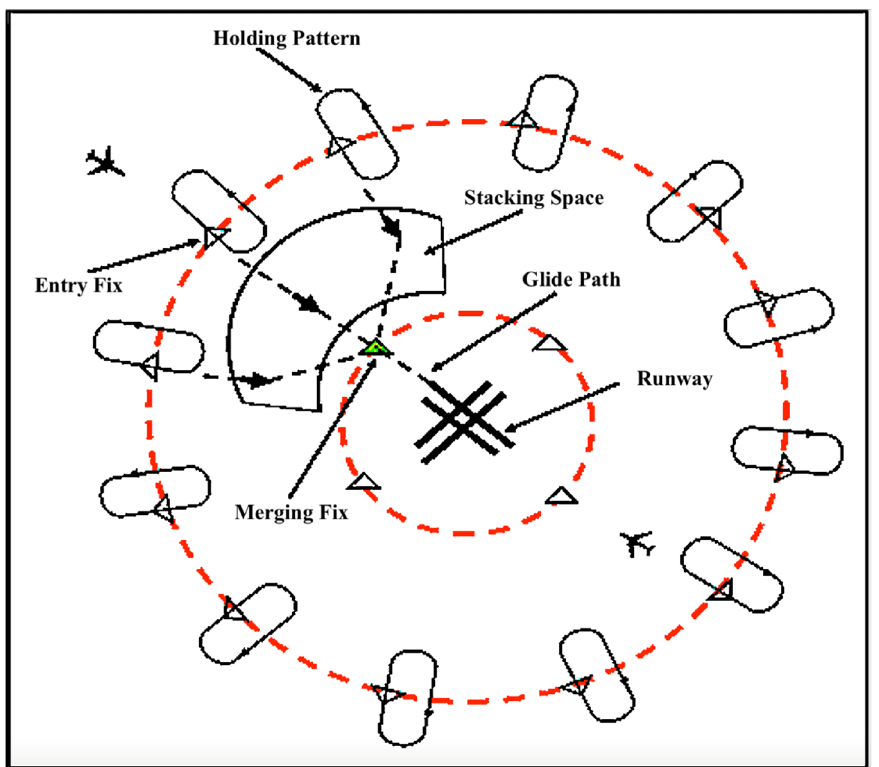
Figure 1. Typical structure of a TMA (top view).